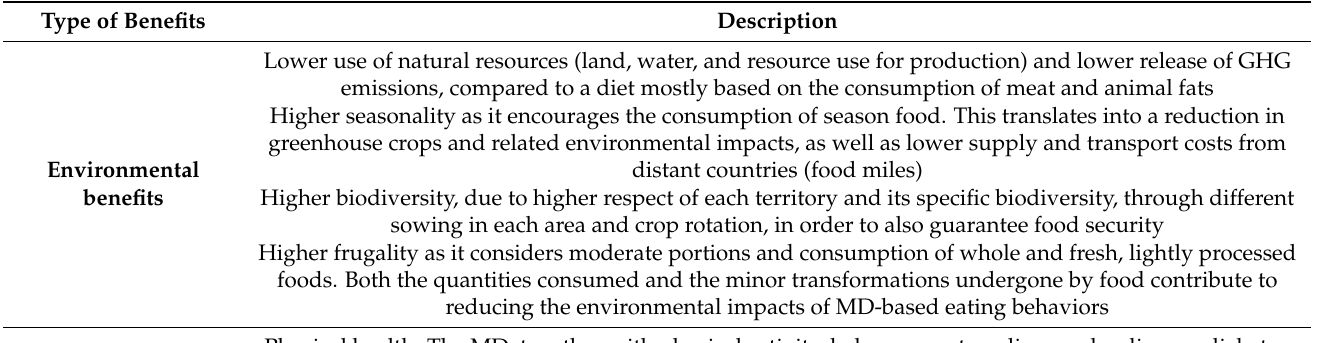
Table 5. Environmental, social, and economic benefits of the